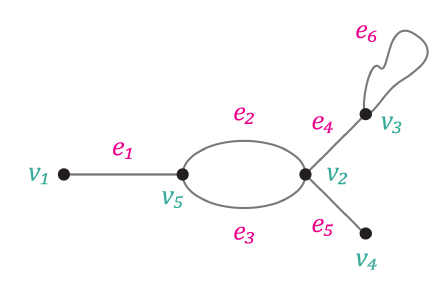
Figure 6. An example illustration of a linear graph